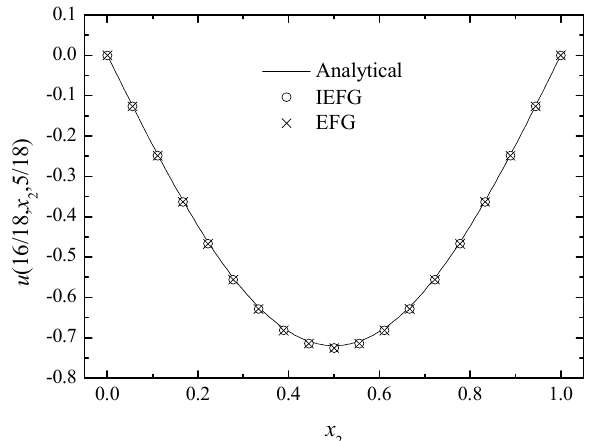
Figure 18. The comparison of the numerical and analytical solutions of the two methods along the x 2 -axis.